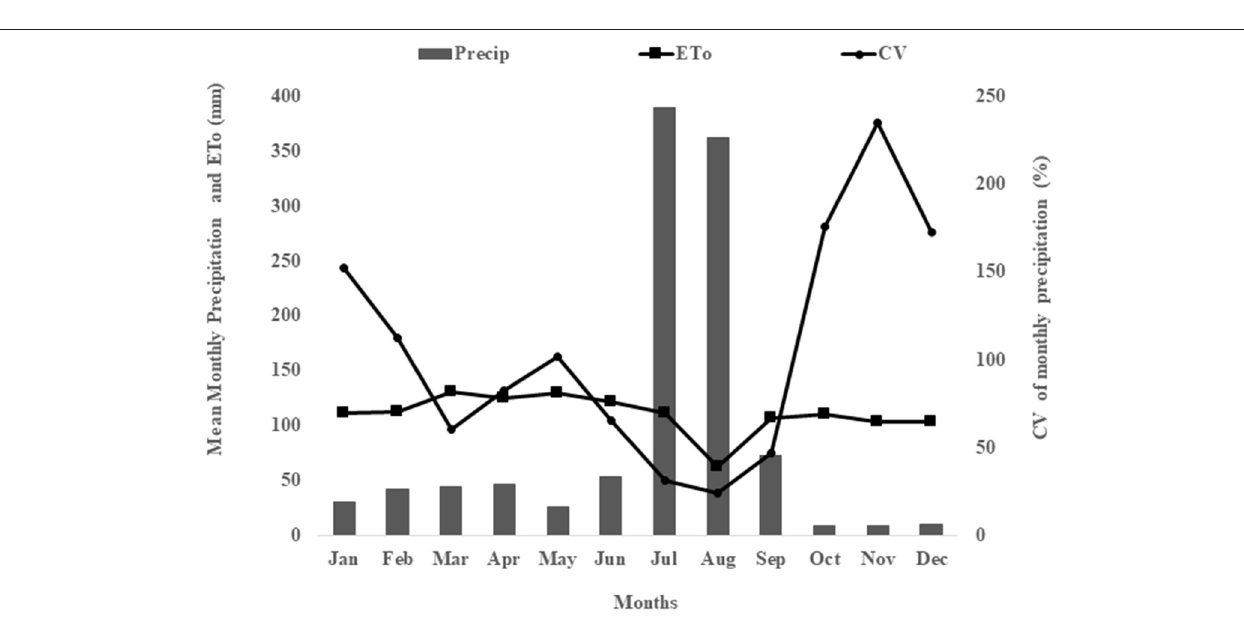
the FAO’s AquaCrop model. The two treatments are one with an optimum fertility level (reference field) and another